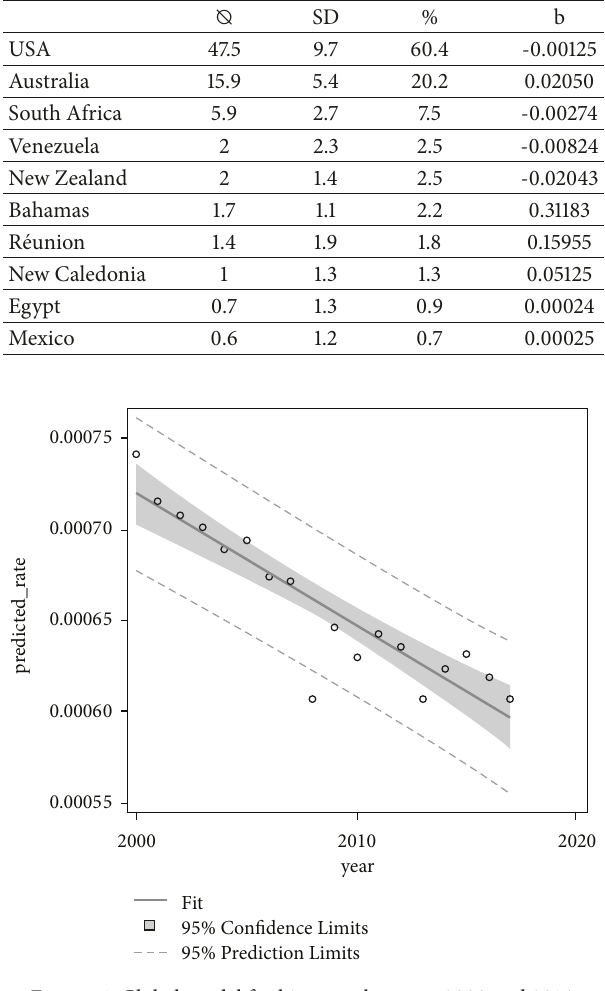
water while the density of the incident-prone shark species decreases at the same time. Still, the number of people entering the water could be influenced by several factors, while the same is true for the sharks. In the following, several of these influencing factors are considered and